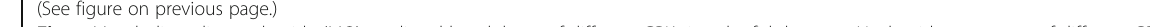
mRNAs in zebrafish. Blue and red underlining indicates GRK-MO1s- and GRK-MO2s-targeted sequences, respectively. The start codons are indicated by brackets. b Images showing whole bodies of 5 dpf larvae injected with control, GRK1b, GRK7a or GRK7b MO1s. Scale bar